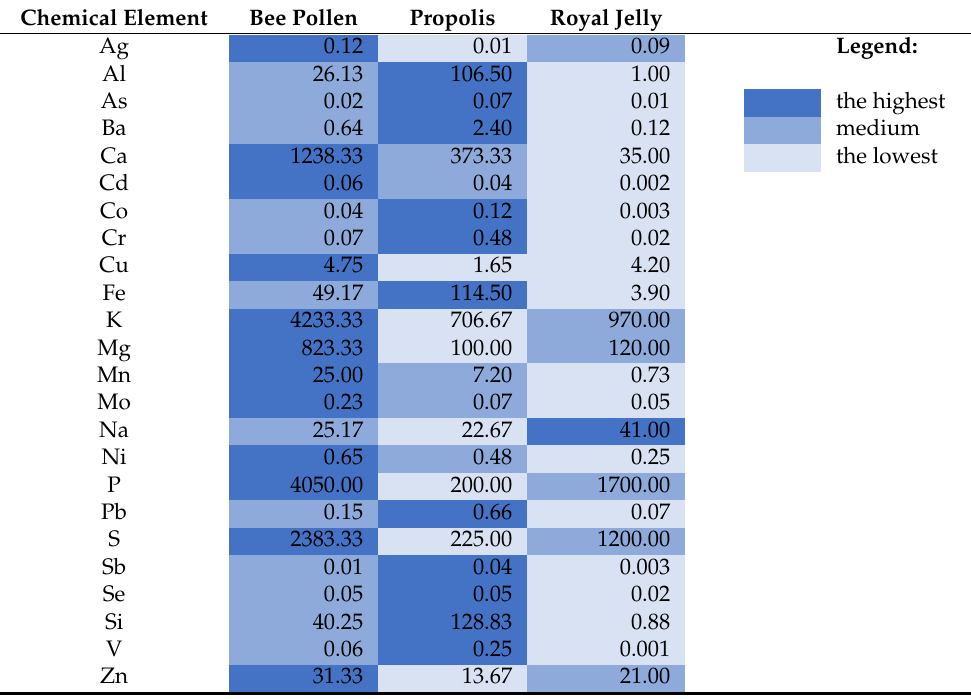
Table 4. Mean values of 24 selected chemical elements determined in bee pollen and propolis and measured levels of elements in the royal jelly sample. Values are expressed in mg/kg. Chemical Element Bee Pollen Propolis Royal